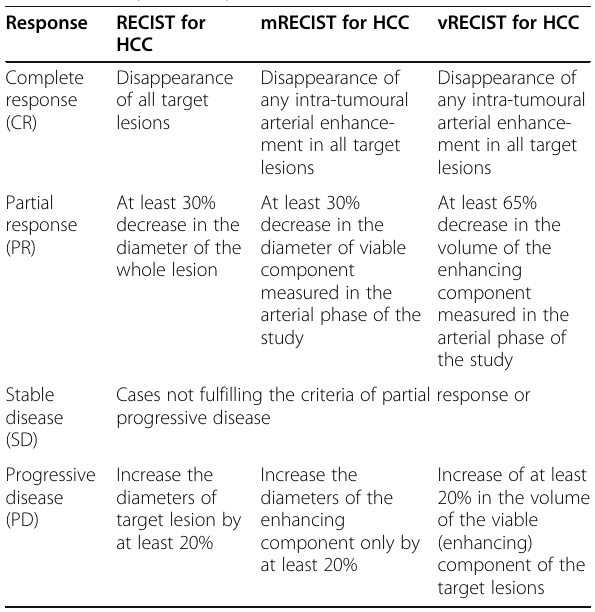
Table 1 Therapeutic response criteria